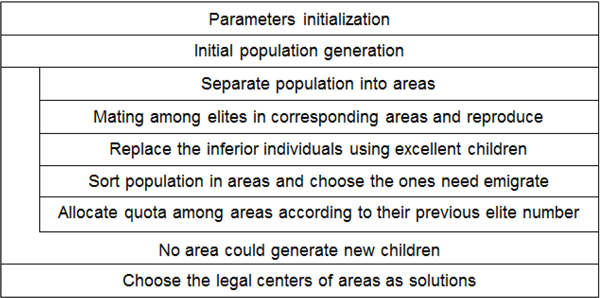
Flow chart of mGA.